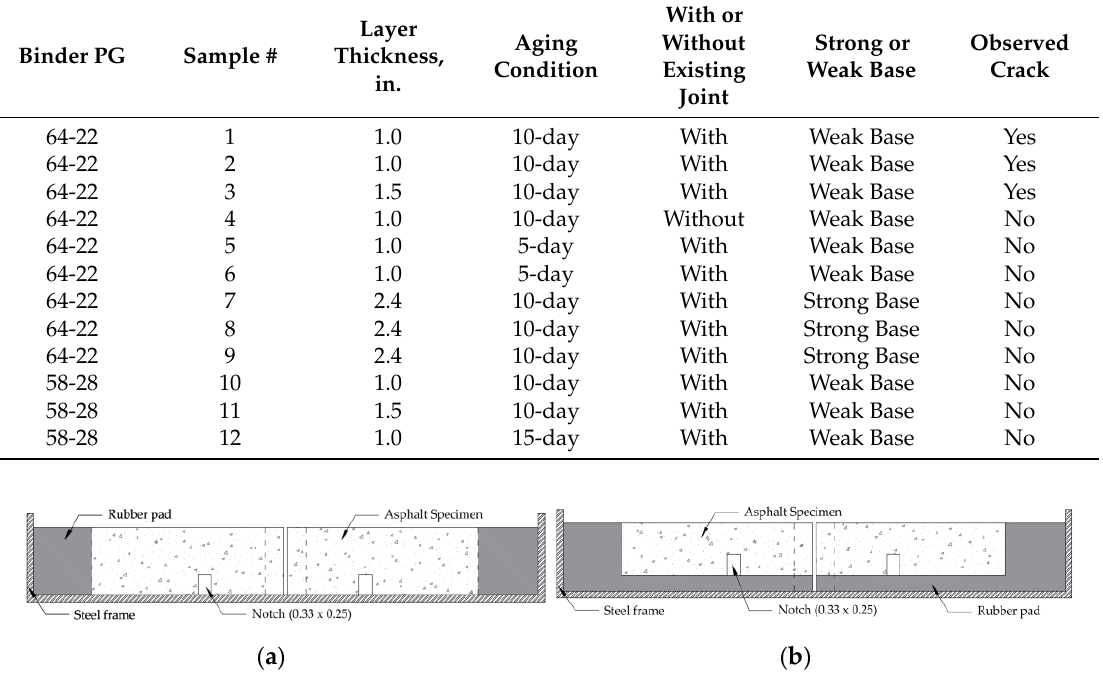
Table 2. Design of test condition.